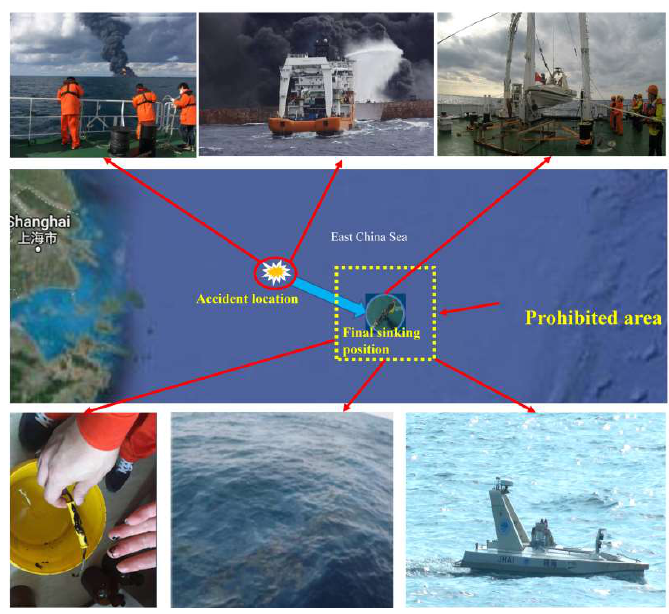
Figure 1. Accident scene.